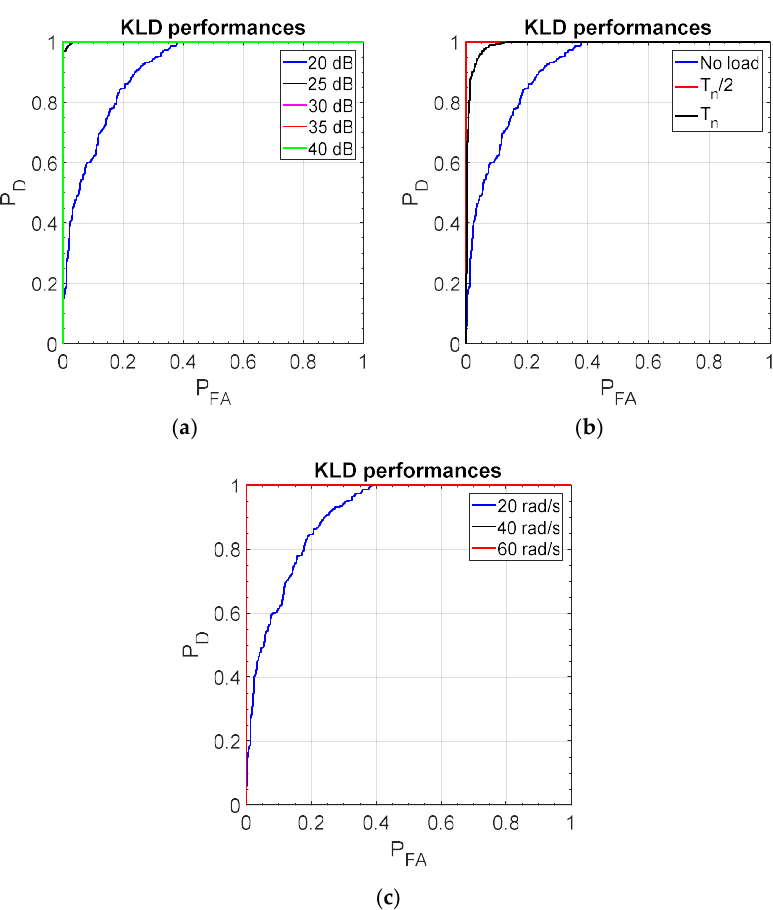
Figure 18. KLD performances for OSF 100 µs with: ( a ) 20 rad/s, 0% of load, ( b ) SNR = 20 dB, 20 rad/s, and ( c ) SNR = 20 dB.